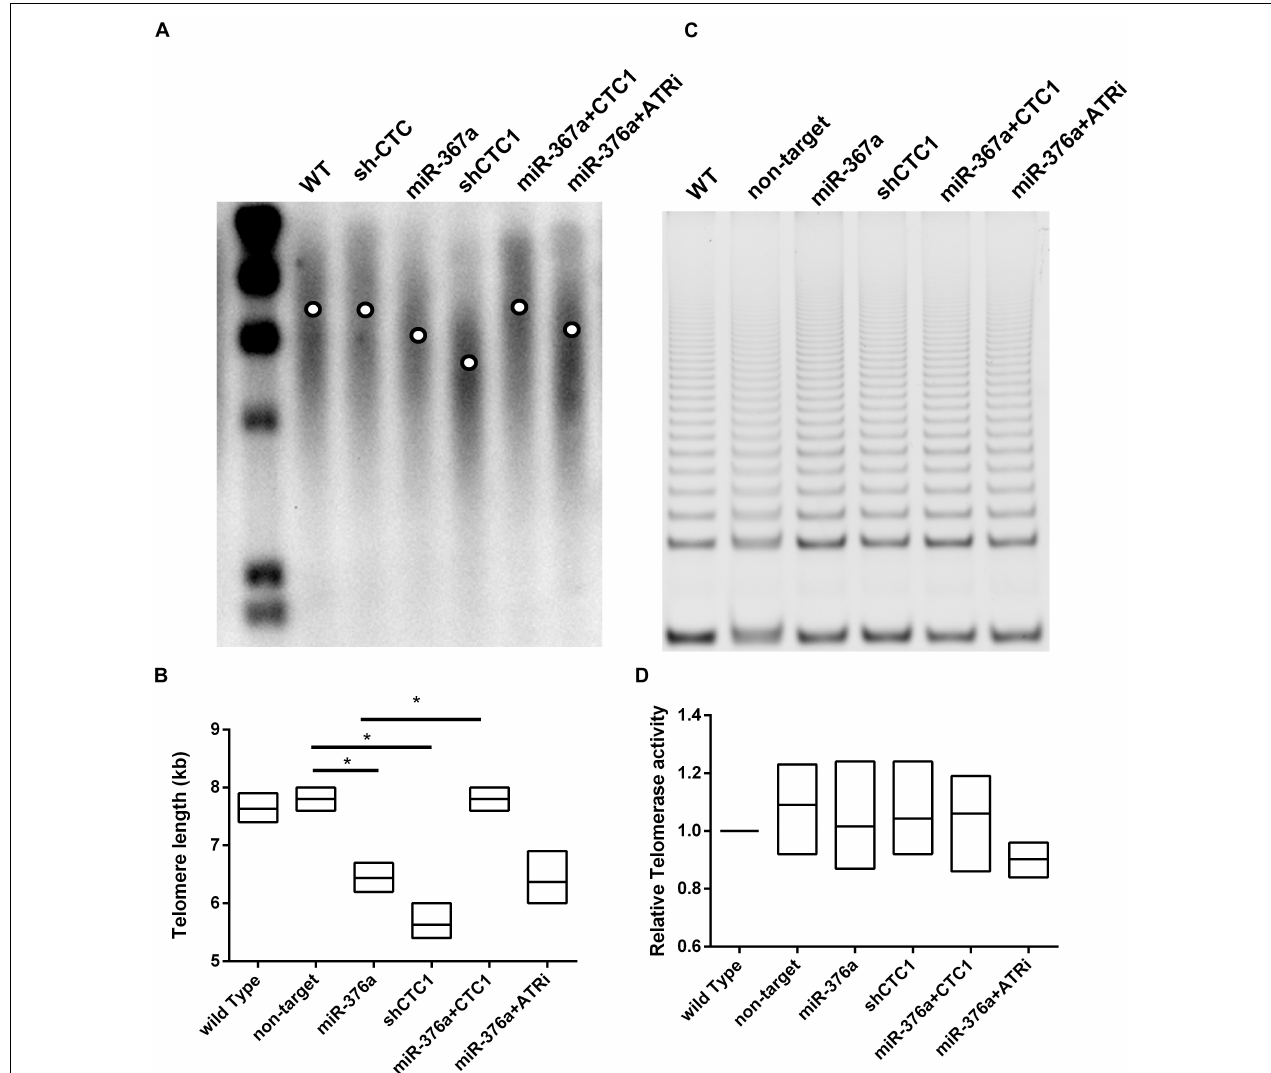
FIGURE 4 | miR-376a causes telomere shortening independent of telomerase. (A) Telomere length was determined by TRF Southern blot; the mean telomere length in each treatment group was labeled by the circle in the lane . (B) The telomere length was calculated and graphed based on the image in graph ( A ). (C) Telomerase activity determined by TRAP assay is demonstrated. (D) The telomerase activity among different treatment groups was calculated and graphed. Statistical analysis was determined by one-way ANOVA, with * P <